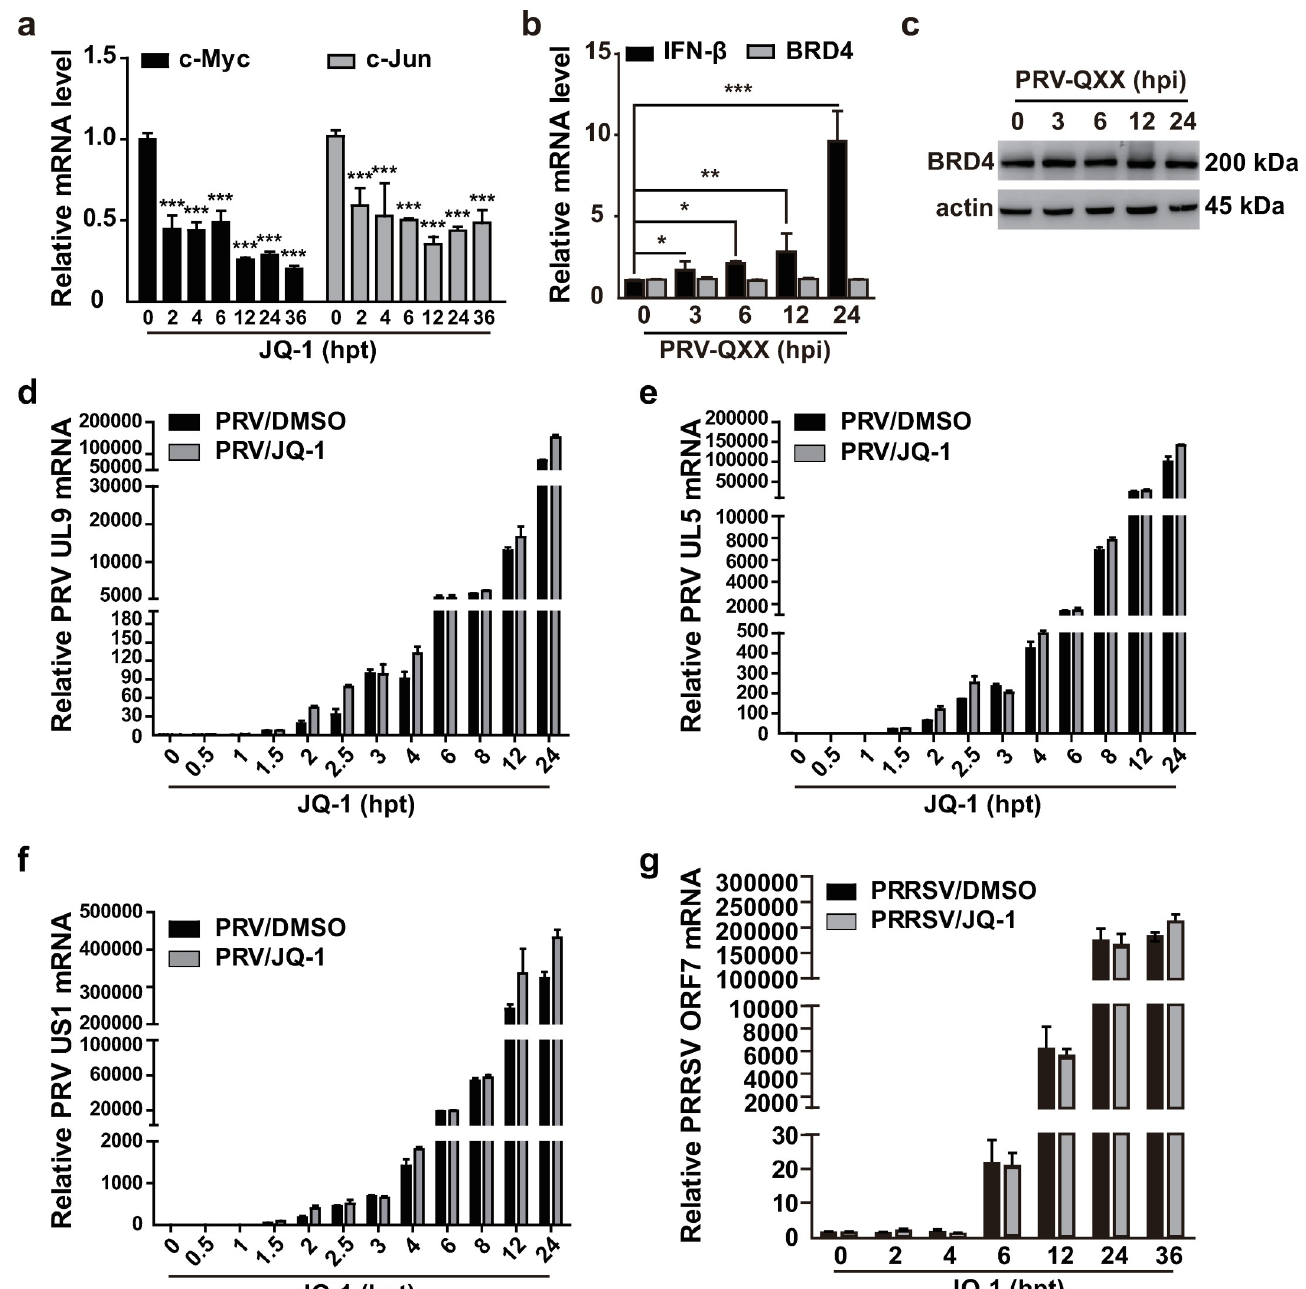
Fig 4. BRD4 inhibition does not impair the transcription of viral genes. (a) c-Myc and c-Jun mRNA were assessed with RT-qPCR analysis in PK15 cells treated with JQ-1 (1 μ M) at 0–36 hpt. Data are shown as mean ± SD based on three independent experiments. ��� P < 0.001 determined by two-tailed Student’s t -test. (b) IFN- β and BRD4 mRNA were assessed with RT-qPCR analysis in PK15 cells infected with PRV-QXX (MOI = 0.1) at 0–24 hpi. Data are shown as mean ± SD based on three independent experiments. � P < 0.05, �� P < 0.01, ��� P < 0.001 determined by two-tailed Student’s t -test. (c) BRD4 expression was assessed with immunoblotting in PK15 cells infected with PRV-QXX (MOI = 0.1) at 0–24 hpi. Actin served as a loading control. (d-f) PRV UL9 (d), UL5 (e) and US1 (f) mRNA were assessed with RT-qPCR analysis in PK15 cells infected with PRV-QXX (MOI = 0.1) and treated with DMSO or JQ-1 (1 μ M) at 0–24 hpt. (g) PRRSV ORF7 mRNA were assessed with RT-qPCR analysis in MARC-145 cells infected with PRRSV-BJ4 (MOI = 1) and treated with DMSO or JQ-1 (1 μ M) at 0–36 hpt.